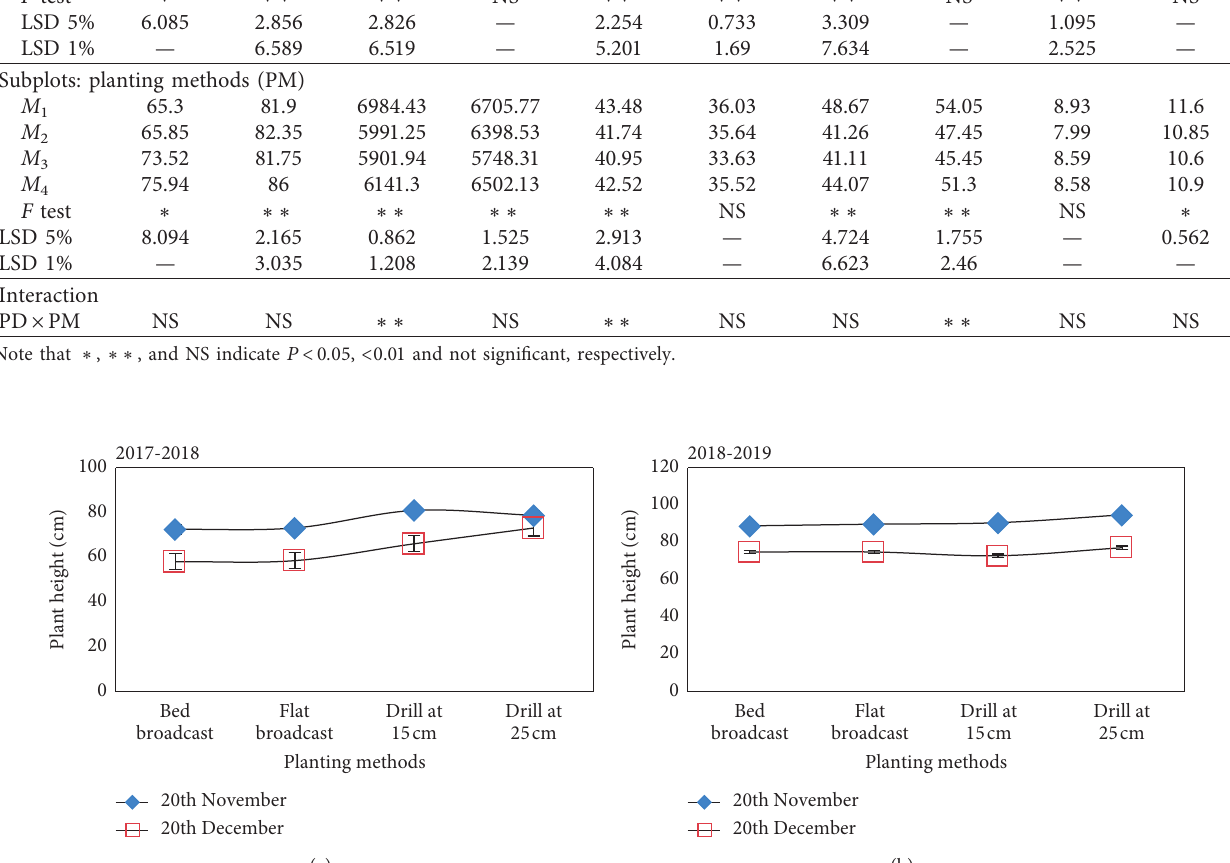
Figure 4. The results indicated that the highest values of